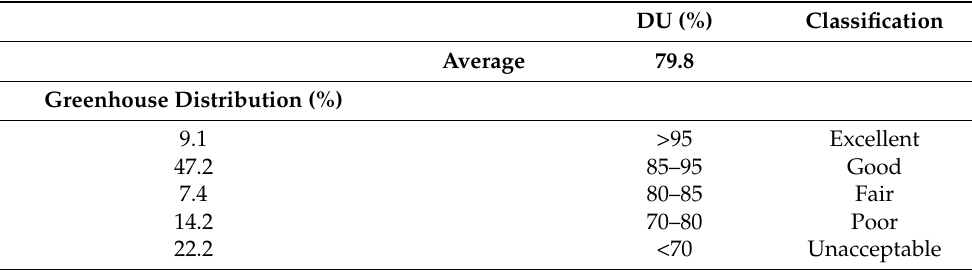
Table 3. Average distribution uniformity (%) in Almer í a greenhouse and distribution (%) of green- houses according to the DU and according to the Merrian and Keller